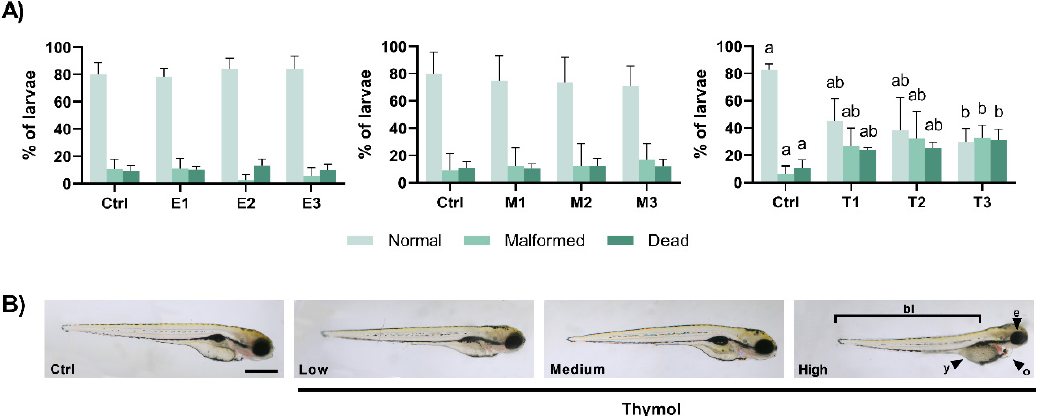
Figure 2. ( A ) Percentages of normal, malformed and dead eleutheroembryo at the end of the exposure period (at 98 hpf). Values are presented as mean ± SD of five replicates per treatment ( n = 10 random embryos per replicate). Different lowercase letters represent statistical differences among treatment groups (one-way ANOVA, p < 0.05). ( B ) Representative views of the malformations observed in eleutheroembryo exposed to Thymol. Malformations were observed after exposure to the highest concentration of Thymol (T3) namely as abnormal eye (e), yolk (y), and pericardiac oedema (o) and by the decreased body length (bl). The scale bar represents 500 μ m.